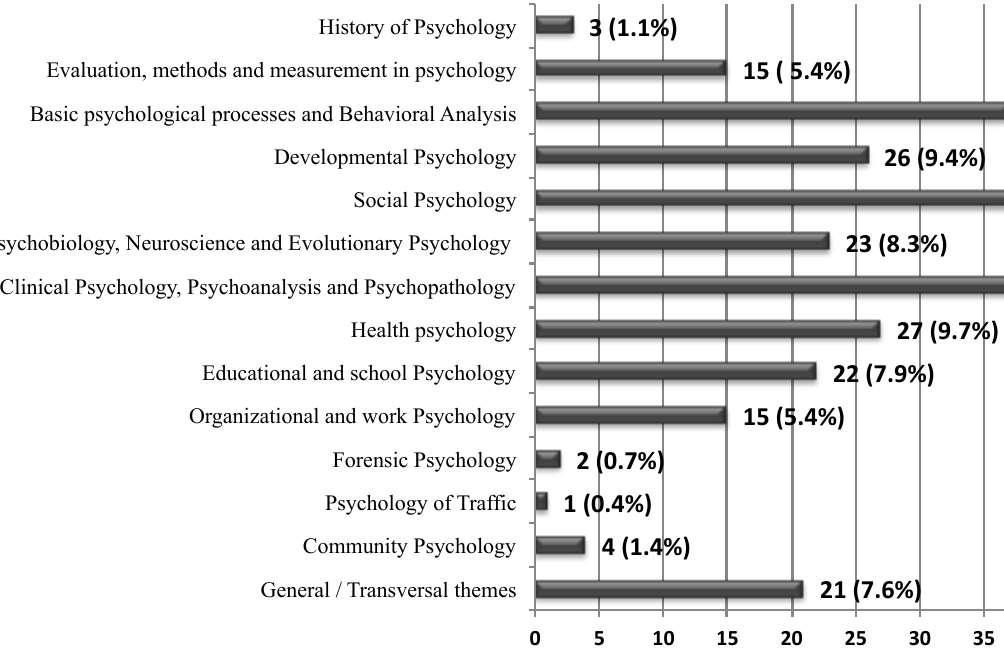
Figure 3. Distribution of the research lines of Brazilian psychology postgraduate programs, in